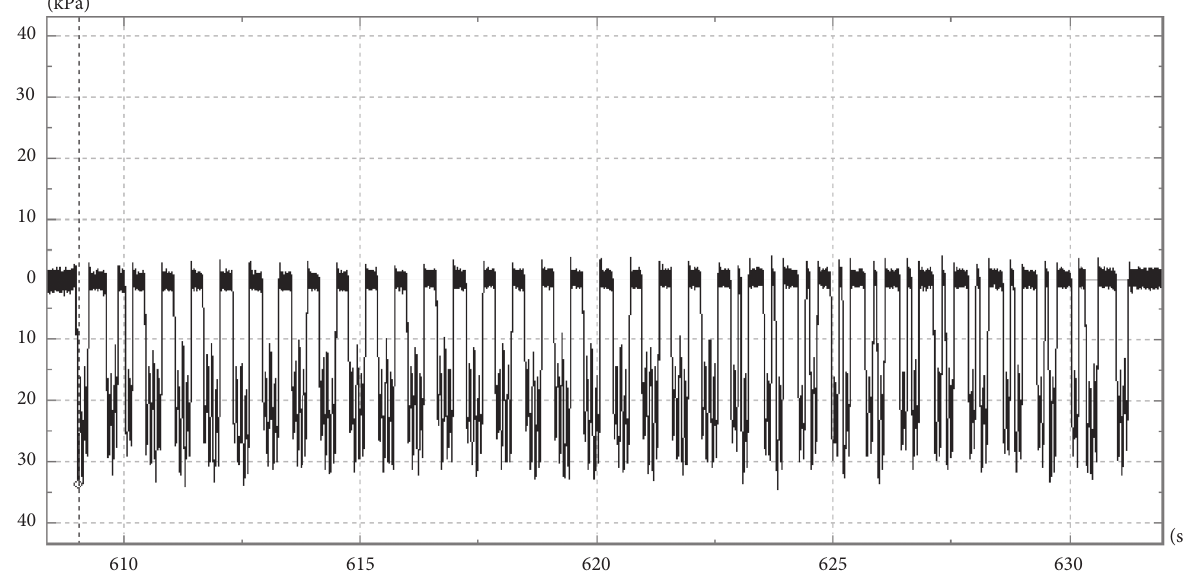
Figure 10: Vertical dynamic stress of the top surface of the filling layer of the wide inverted arch in the cracked